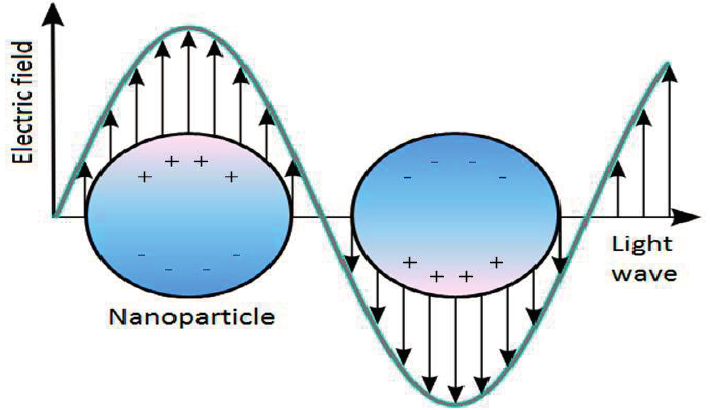
Figure 1. Schematic diagram illustrating the localized surface plasmon on a nanoparticle surface. This resonant oscillation produces large, wavelength-selective increases in absorption, scattering, and